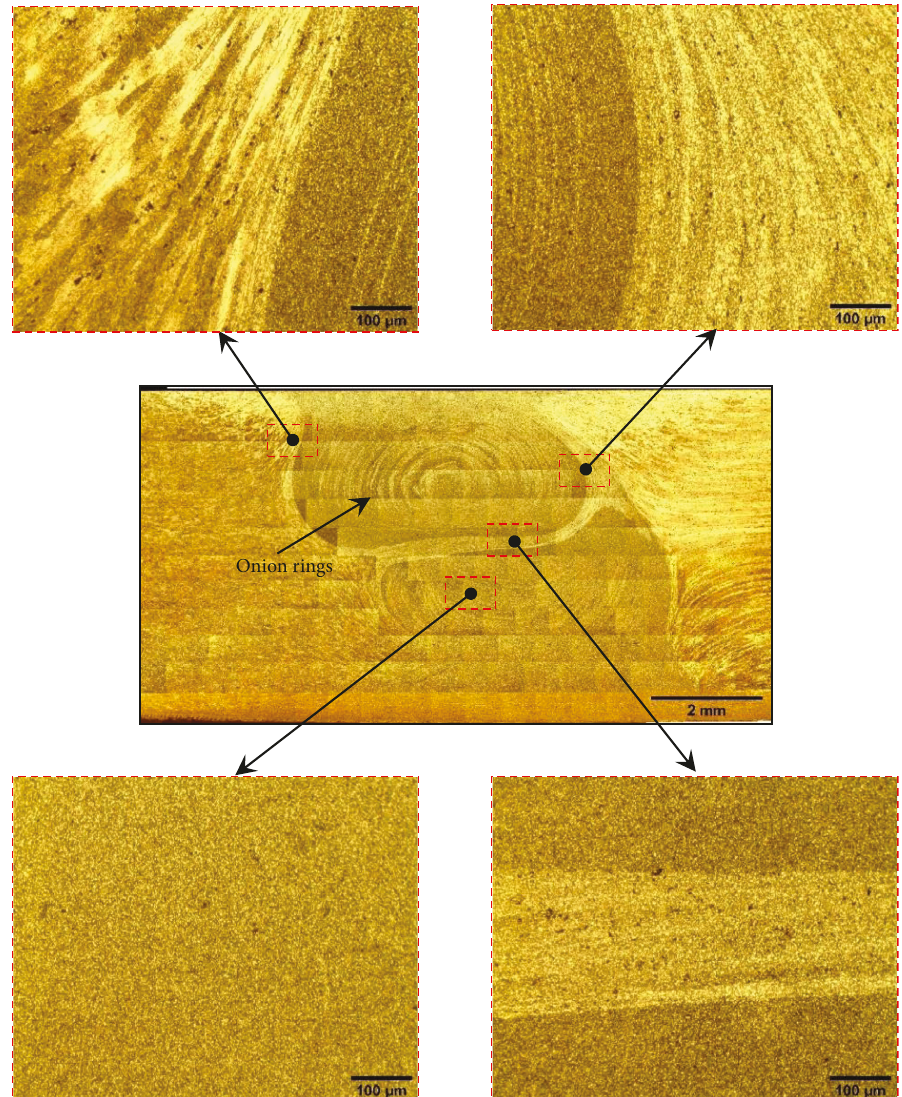
Figure 4: Microstructure examination of the DS-FSW at 102mm/min welding speed.